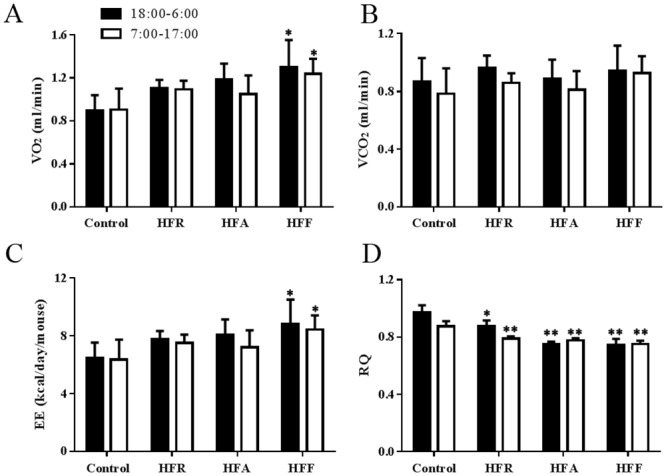
Effect of diet modification on the basal metabolic rate.The levels of the consumed O2 (VO2, A), the produced CO2 (VCO2, B), energy expenditure (EE, C), and respiratory quotient (RQ, D) were examined in the control, HFR, HFA and HFF mice. Data are presented as means ± SD (n = 5 in each group). A significant difference was determined by one-way analysis of variance. *P<0.05 versus control in the same phase, **P<0.01 versus control in the same phase.